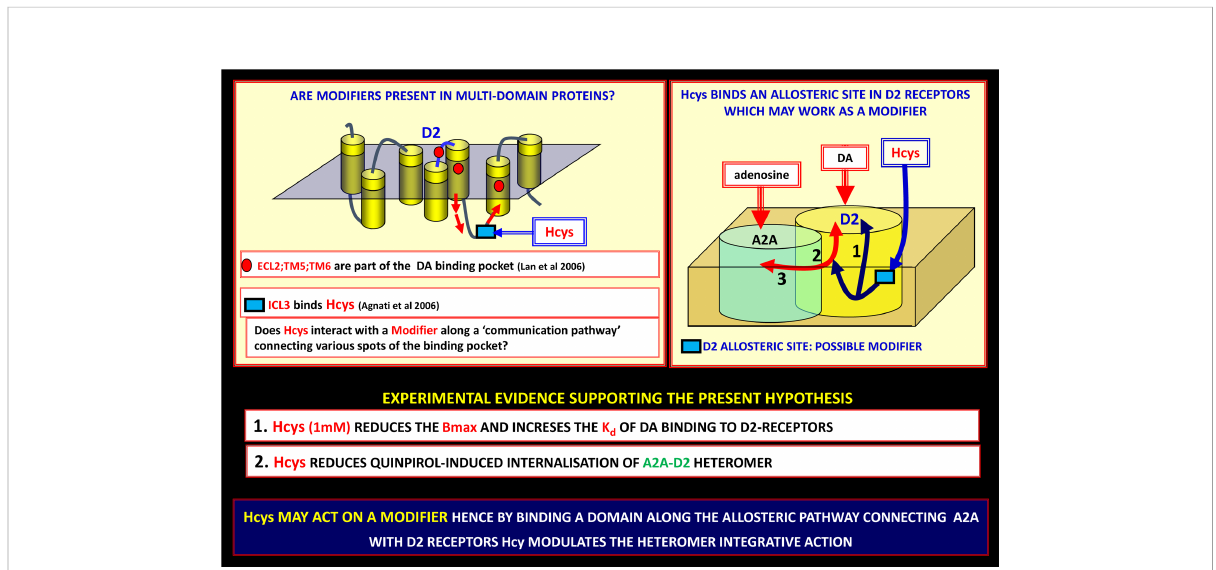
FIGURE 5 On the possible existence of modi fi ers along the allosteric communication channels in receptor heteromers. Allosteric communication in receptor heteromers (Receptor Mosaics, RMs) can be modulated by modi fi ers. Along the allosteric pathway connecting A 2A with D 2 receptors, homocysteine (Hcys) can modulate the heteromer integrative action. Left panel: the Hcys allosteric binding site is an epitope on the ICL3 of D2- R, hence it can ef fi ciently modulate two out of three of the domains involved in the binding pocket of the D 2 receptor (for experimental procedures see (141)). This fi nding can be of great importance since indicates a new pharmacological approach to produce a biasing action on RMs involved in PD. Lan et al., 2006 (142); Agnati et al., 2006 (141). DA, dopamine; ECL, extracellular loop; ICL, intracellular loop; PD, Parkinson ’ s disease; TM,